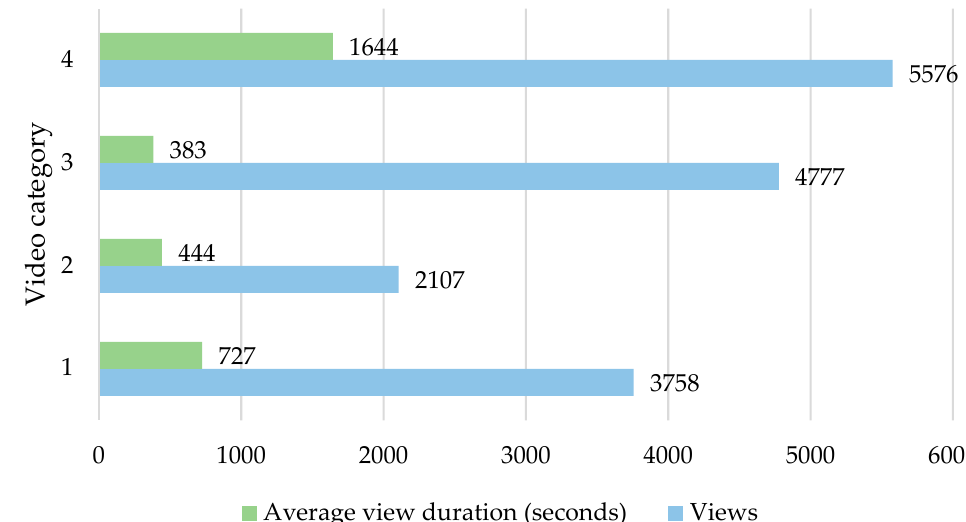
Figure 2. Average viewing time and number of views by video category.